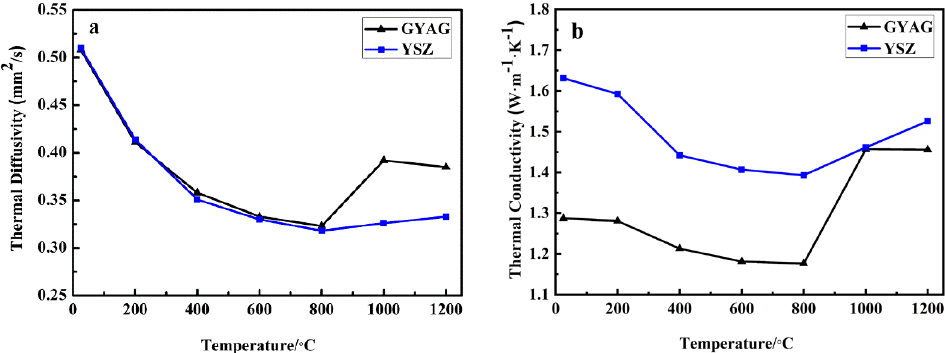
Figure 7. Thermal diffusivities ( a ) and thermal conductivities ( b ) of GYAG and YSZ ceramic coatings.